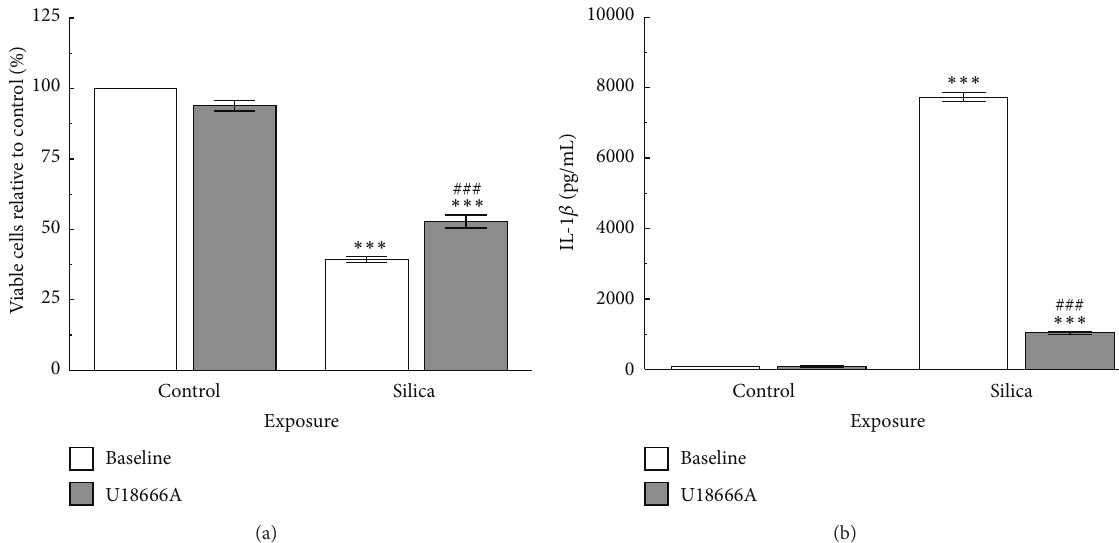
Figure 9: Cholesterol trafficking modifier U18666A decreases WT AM response to silica (50 𝜇 g/mL). (a) Cell viability at 24 hrs after particle exposure by MTS assay. (b) IL-1 𝛽 release 24 hrs following silica exposure cocultured with LPS (20ng/mL) to stimulate NF- 𝜅 B activation. Asterisks ∗∗∗ indicate statistical significance at 𝑃 < 0.001 compared to corresponding control condition. Hashtags ### indicate significance at 𝑃 < 0.001 compared to baseline silica-exposed response, 𝑛 = 3